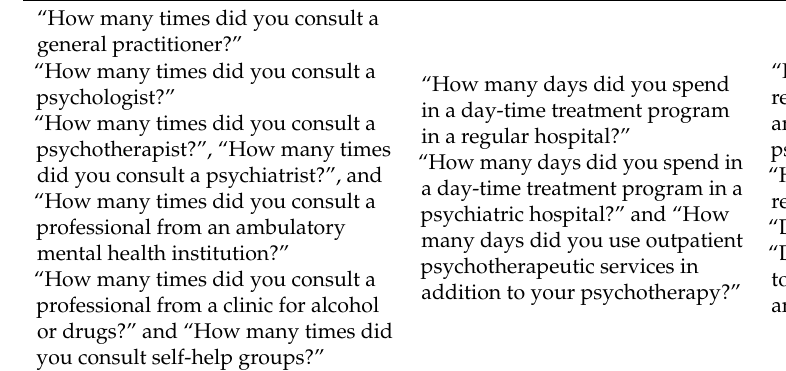
Table 1. TiC-P items included in the